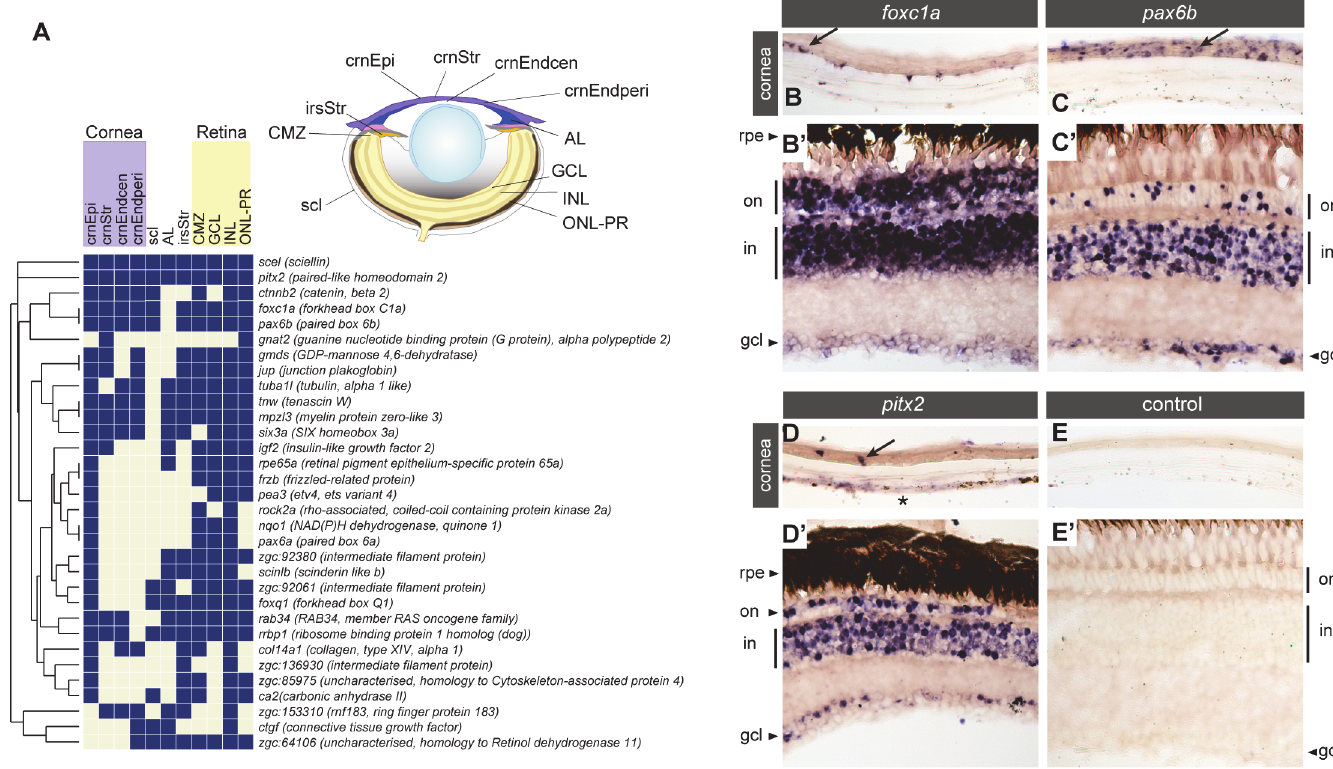
Fig 3. Genes expressed in the cornea are also expressed in the retina of the adult eye. (A) Analysis of genes and their expression in structures of the adult zebrafish eye. The 32 genes examined are listed along the vertical axis. The examined anatomical structures are shown in the schematic and listed on the horizontal axis. Anatomical structures examined are inner nuclear layer of the retina (INL), iris stroma (irsStr), outer nuclear layer and outer plexiform layer (ONL-PR), ganglion cell layer (GCL), ciliary marginal zone of the retina (CMZ), corneal epithelium (crnEpi), annular ligament (AL), sclera (scl), corneal stroma (crnStr), peripheral region of the corneal endothelium (crnEndperi) and central region of the corneal endothelium (crnEndcen). (B-E): Examples of genes expressed in the cornea and the retina. in situ gene expression patterns of foxc1a (B, B ’ ), pax6b (C, C ’ ) and pitx2 (D, D ’ ) are shown in the adult cornea (B-D) and retina (B ’ -D ’ ), with tissue processed without antisense mRNA probe as a negative control (E, E ’ ). Genes expressed in either the corneal epithelium (arrows) or the corneal endothelium (asterisk) are also expressed in the retina. rpe: retinal pigment epithelium; on: outer nuclear layer; in: inner nuclear layer; gcl: ganglion cell layer. Scale bar: 50 μ